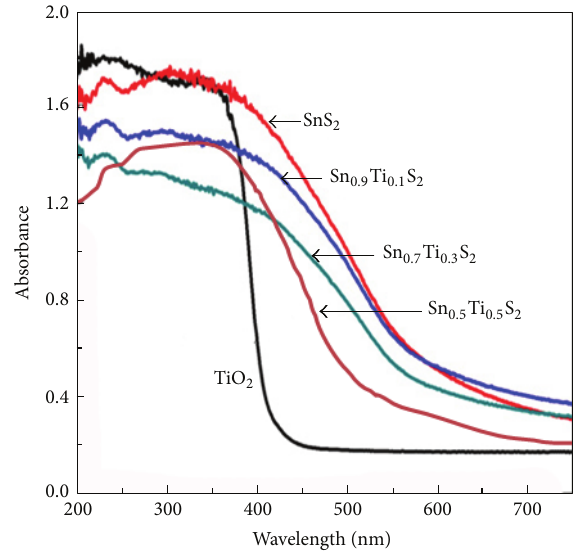
Figure 4: UV-visible diffuse reflectance spectra of the as-synthesized SnS 2 and Sn 1−